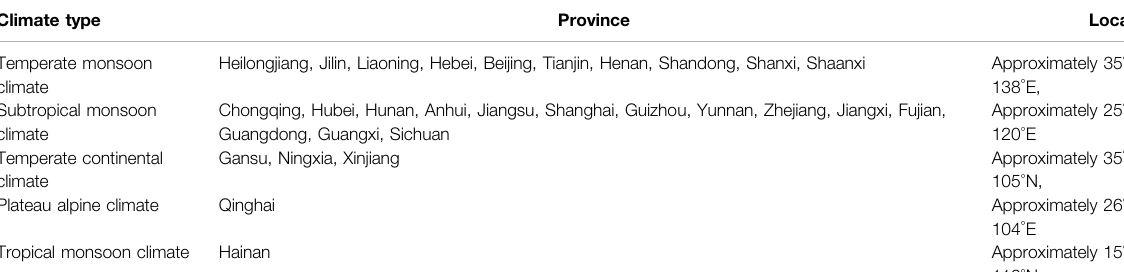
TABLE 1 | The division of fi ve climatic regions for grain yield in China.